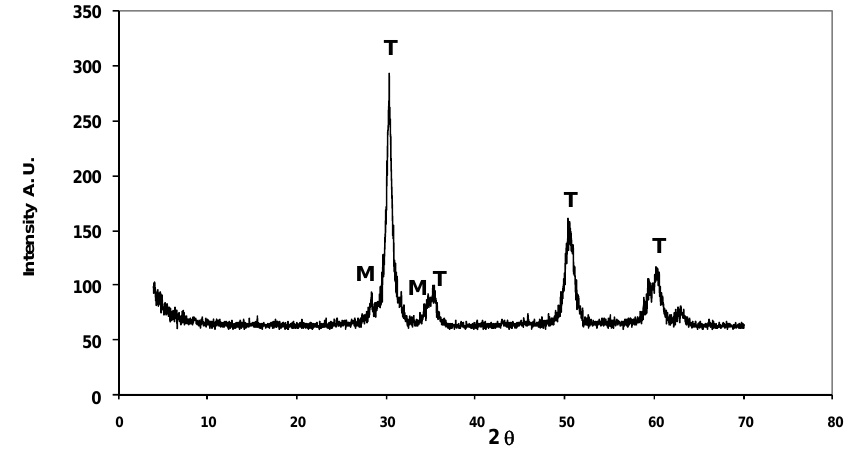
Figure 1. X-ray difraction of the Pt/SZ catalyst after calcination at 873